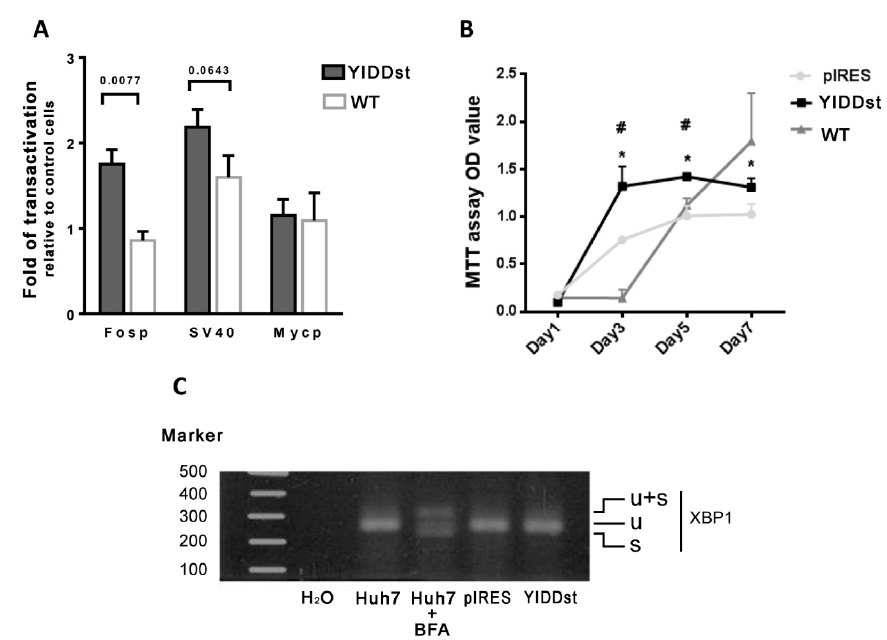
Figure 2. Assays of the transactivation, cell proliferation, and endoplasmic reticulum (ER) stress response. ( A ) Fold change of the dual-luciferase reporter assay relative to the mock control shows a higher transactivation of c-fos and SV40 in YIDDst than wild type (WT) cotransfection. ( B ) Cell proliferation with 3-(4, 5-dimethylthiazol-